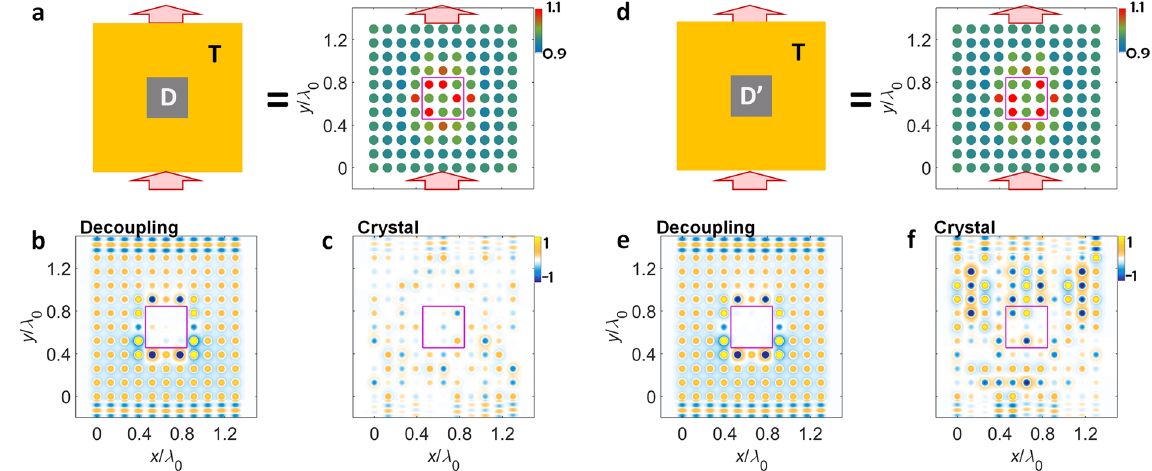
Figure 2. Demonstration of eigenstate decoupling for planewave input and output waves through the crystal lattice. The different configurations in the decoupled region are compared for the cases of ( a–c ) and ( d–f ) (D ≠ D’, red boxes in the right panels of ( a,d )). The decoupling results in ( b,e ) are compared with the results